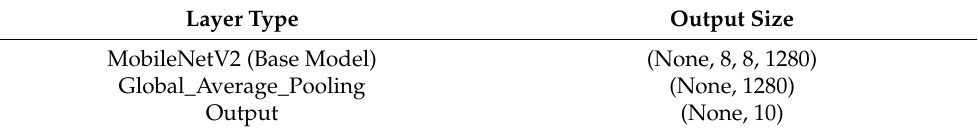
Table 2. The architecture used to train MobileNetV2 model using feature extraction and fine- tuning methods.